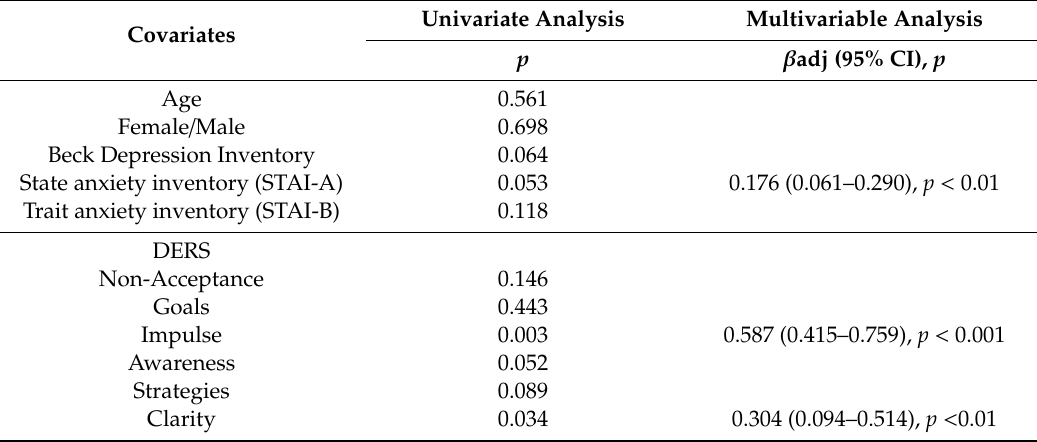
Table 6. Multiple linear regression analysis of the association between BITE subscale (severity score) and sociodemographic and clinical characteristics in the BED